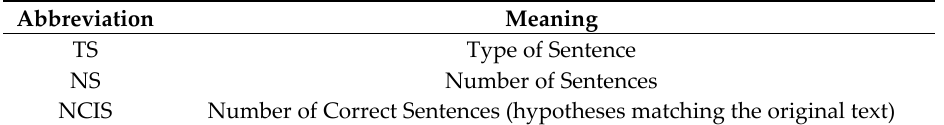
Table 3. Map key of the result table (Table